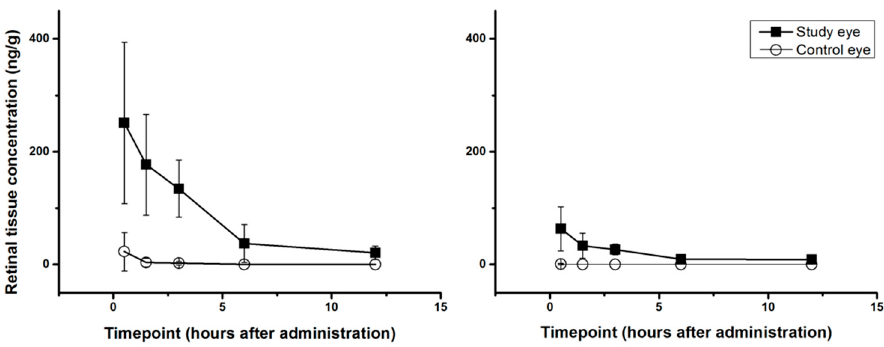
Figure 1. Retinal tissue concentrations of irbesartan ( left ) and candesartan ( right ) in the study and control eye. Data are shown as means ± SD.